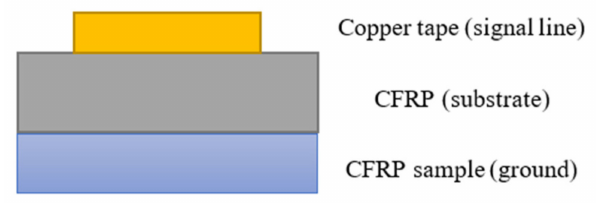
Figure 9. Self-sensing sensor